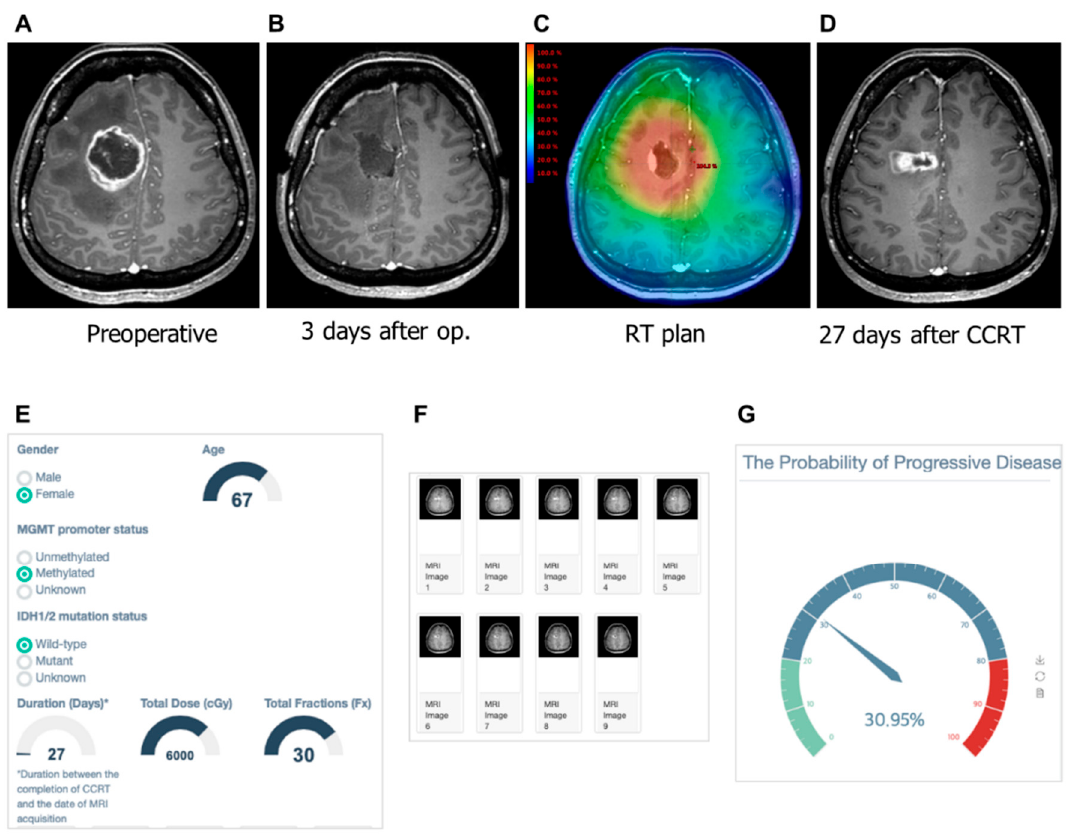
Figure 5. Gadolinium-enhanced T1-weighted magnetic resonance (MR) images from a 45-year-old woman with glioblastoma and the clinical application of the machine learning model. ( A ) Pre-operative MR image showing an enhanced lesion. ( B ) No residual enhancing lesion in the cavity after the gross total resection. ( C ) Radiation therapy plan image showing the isodose line. ( D ) Enhancing lesion appeared in the resection cavity within the 80% isodose line after the completion of concurrent chemoradiation. ( E ) The screenshot of clinical information is given to the web platform. ( F ) Nine MR images are selected and uploaded to the platform. ( G ) Gauge figure representing the probability of progressive disease.